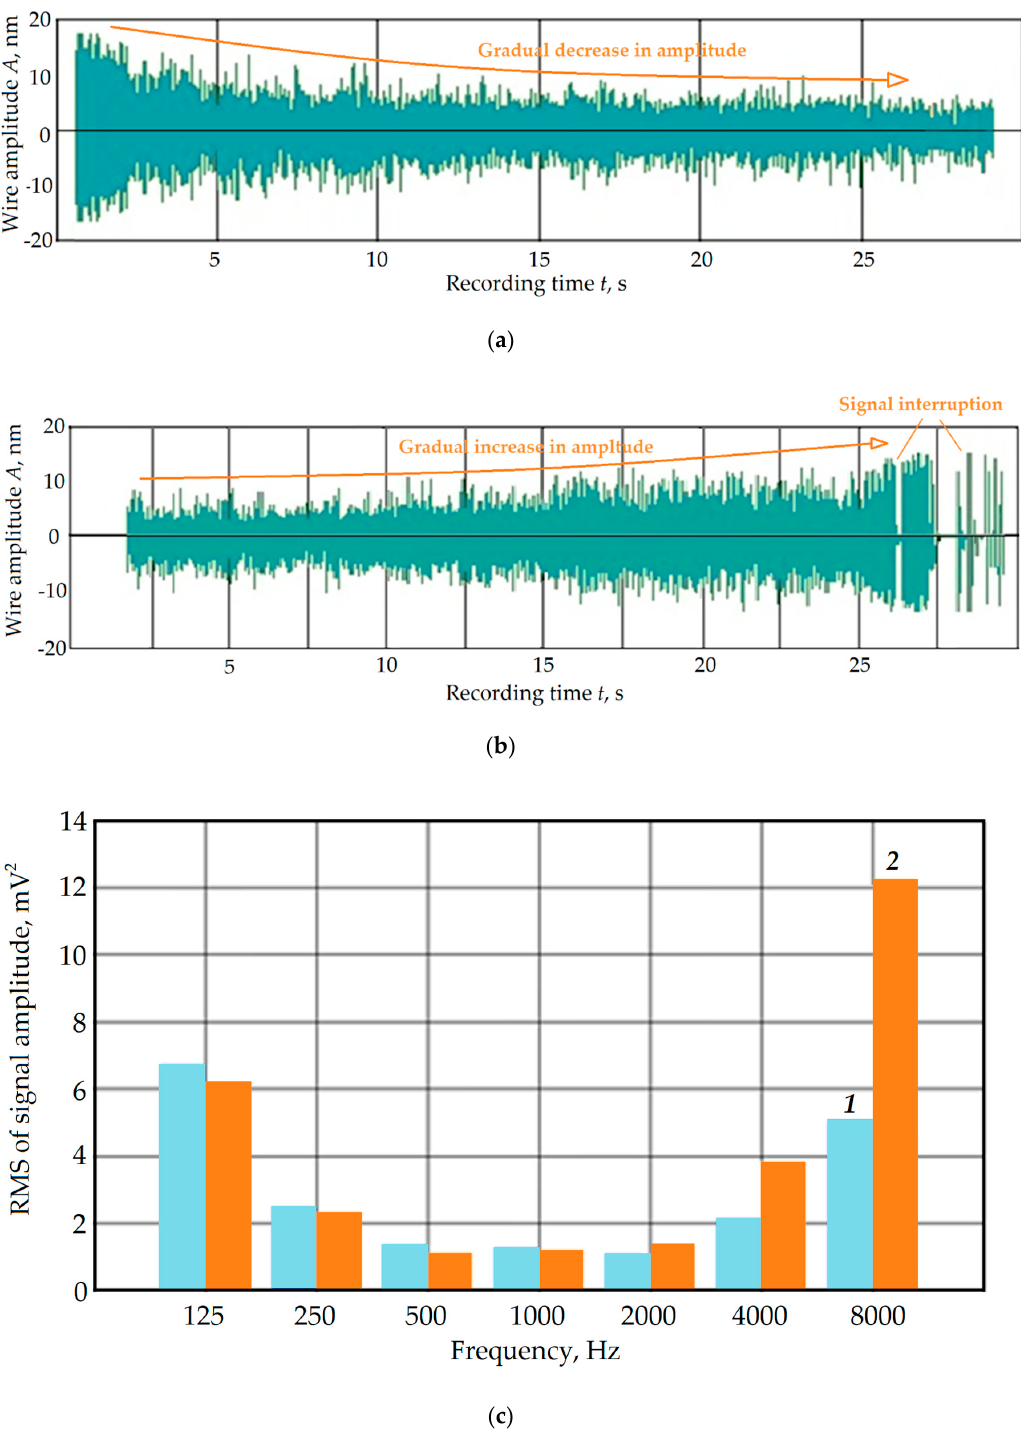
Figure 4. Recorded signal and its root-mean-square value during electrical discharge machining of 12Kh18N10T (AISI 321) samples: ( a ) at 30 s of the tool penetration into the workpiece; ( b ) at 30 s before the end of the processing; ( c ) octave spectra of the root-mean-square value of the signal amplitude of 24.5 g sample, V 0 = 65 c.u., W t = 35 c.u., where ( 1 ) at 30 s before the end of the operation, ( 2 ) at 5 s. Octave spectra of the root-mean-square value of the signal amplitude (RMS) in Figure 4c showed that RMS differs more than 2.5 times at 60 s and 5 s at a frequency band of 4 ÷ 8 kHz. Simultaneously,